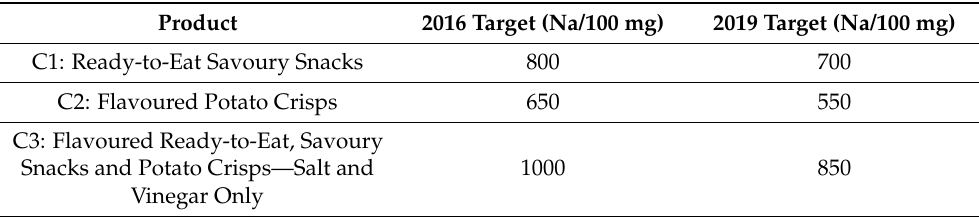
Table 1. Reduction in total sodium content (Na) of certain foodstuffs (Source: Department of Health,